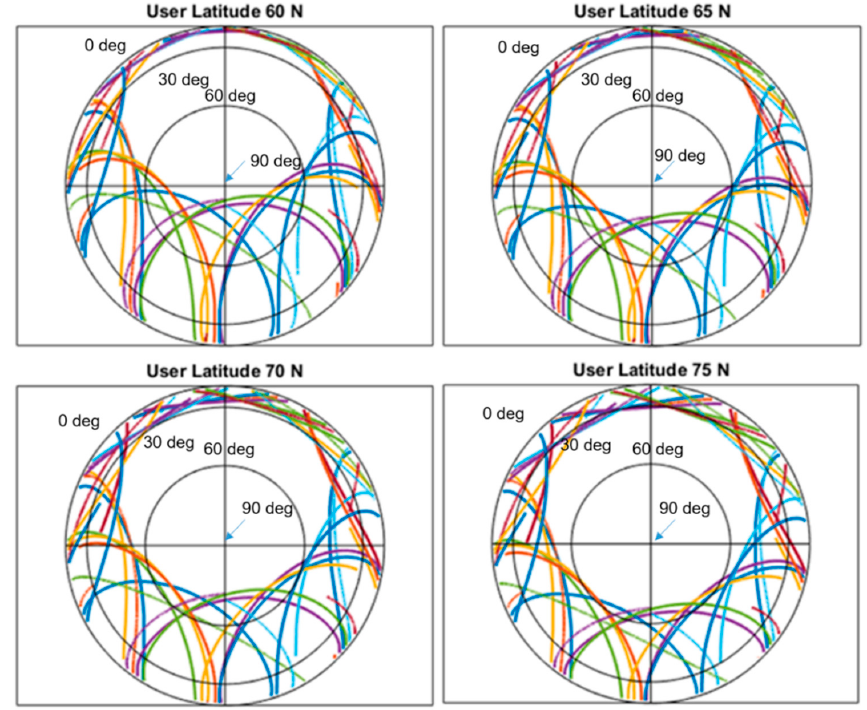
Figure 3. Skyplot for users at different latitudes. Different satellite passages are depicted with different colors.